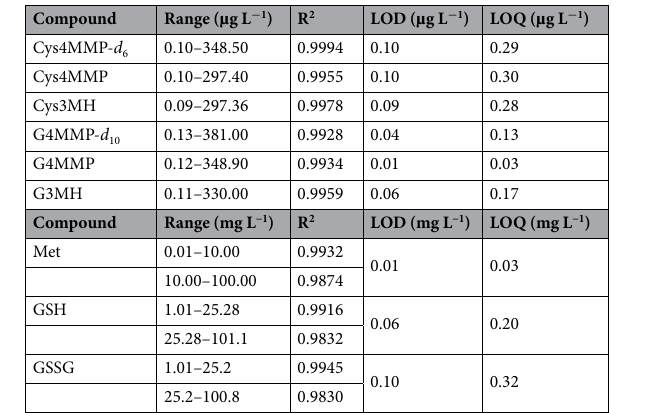
Table 1. Linearity, limit of detection (LOD), limit of quantification (LOQ) for thiol precursors, GSH, GSSG and Met.